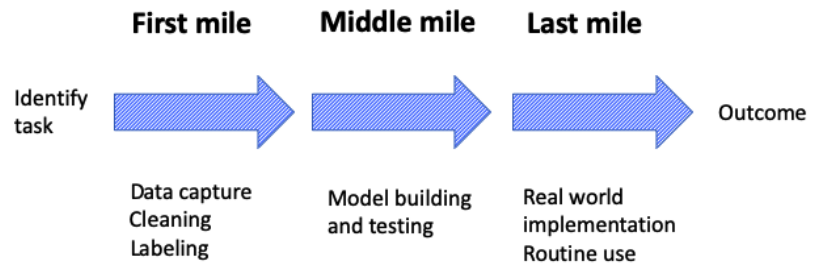
Figure 1. Three stages in the development of artificial intelligence